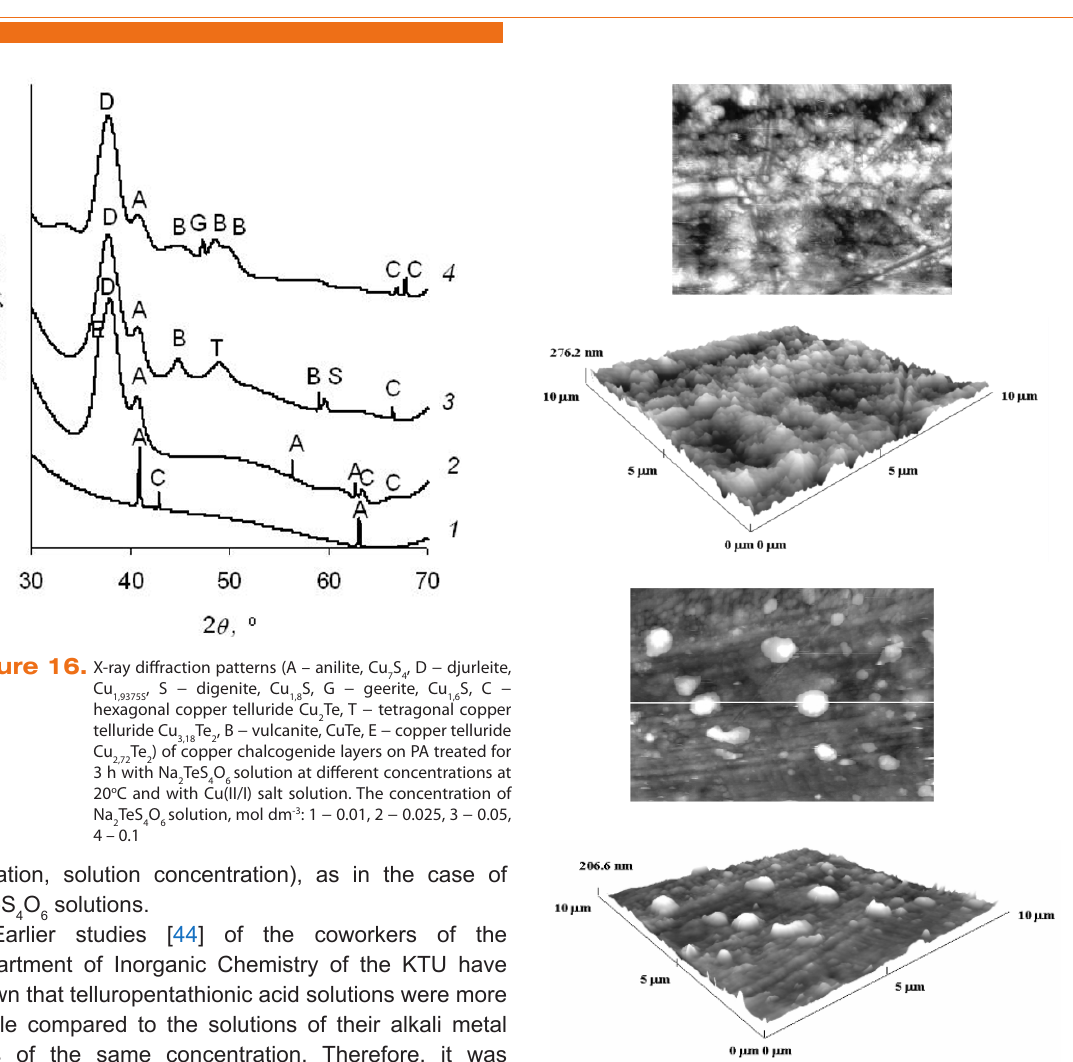
treated: a) for 3 h at 20 o C in 0.1 mol dm -3 Na H